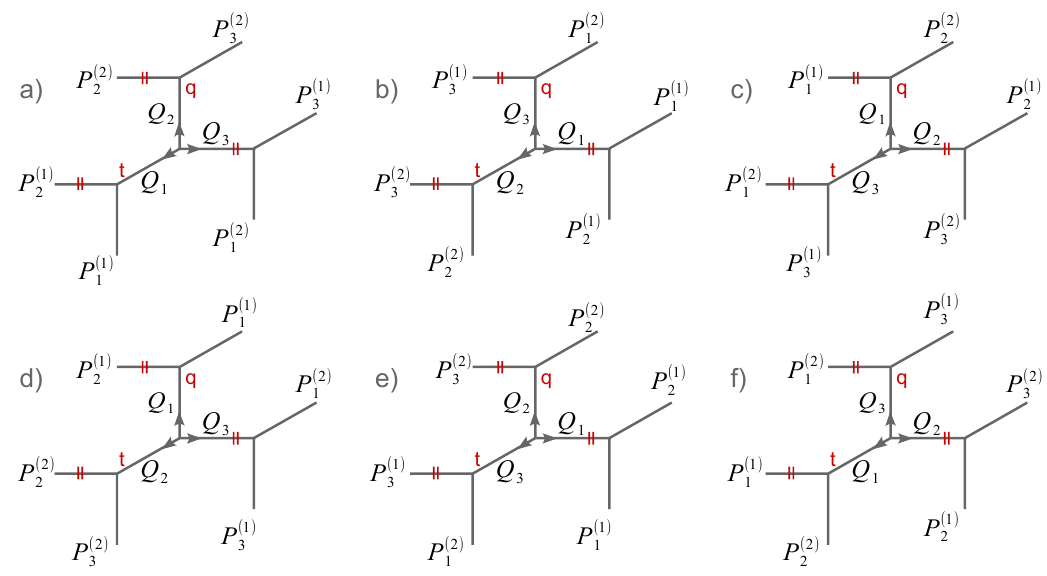
Figure 5 . The upper (cid:12)gures a ), b ) and c ) correspond to the three di(cid:11)erent ways to choose the preferred direction while the three lower (cid:12)gures d ), e ) and f ) correspond to the three re(cid:13)ections over the middle axis labeled by the preferred